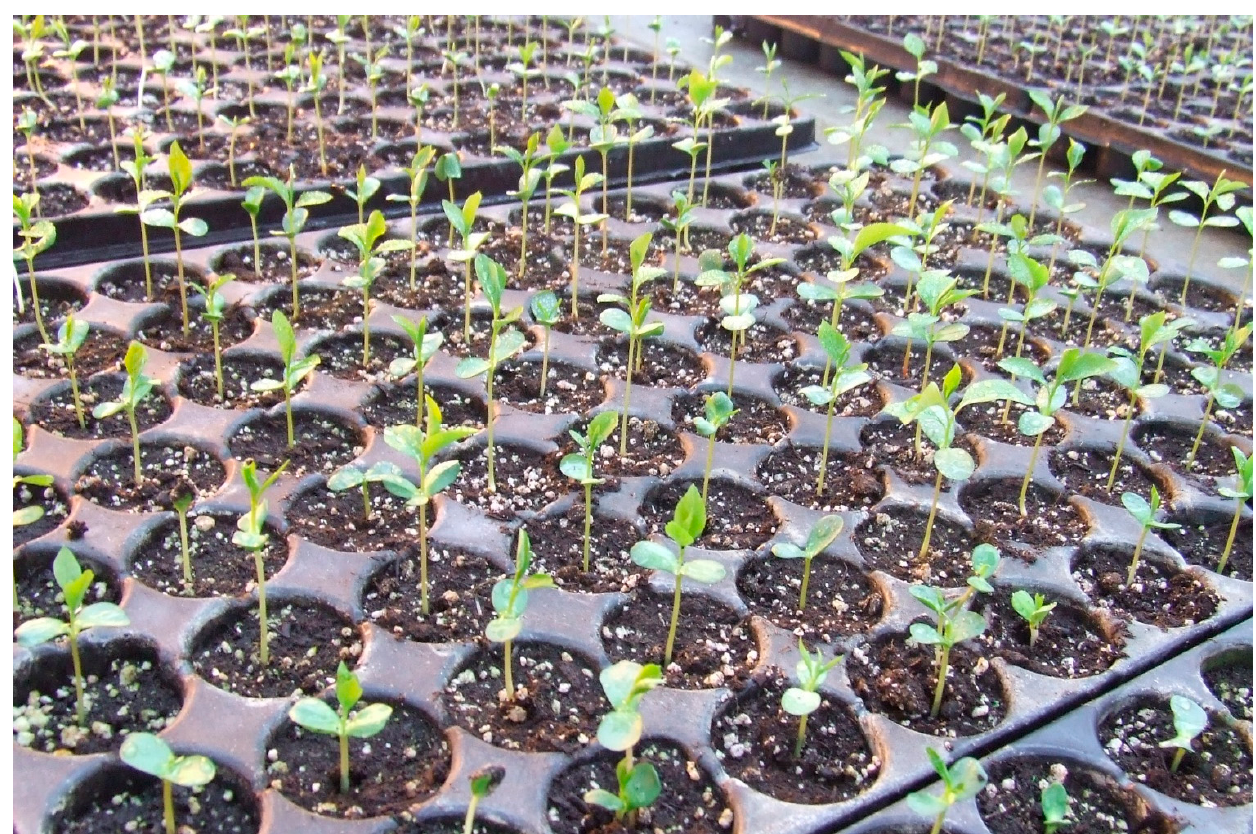
Figure 2. Pear seedlings in the greenhouse.